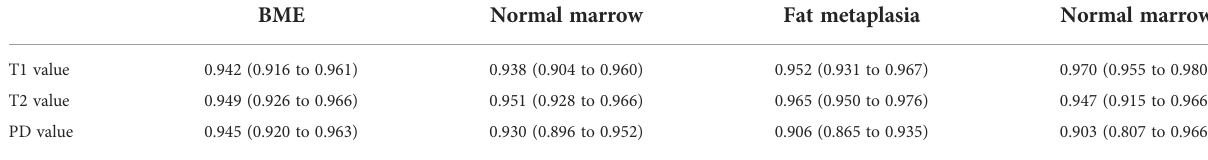
TABLE 3 Inter-reader agreement (mean difference and, in parentheses, 95% con fi dence intervals) of T1, T2, and PD values.